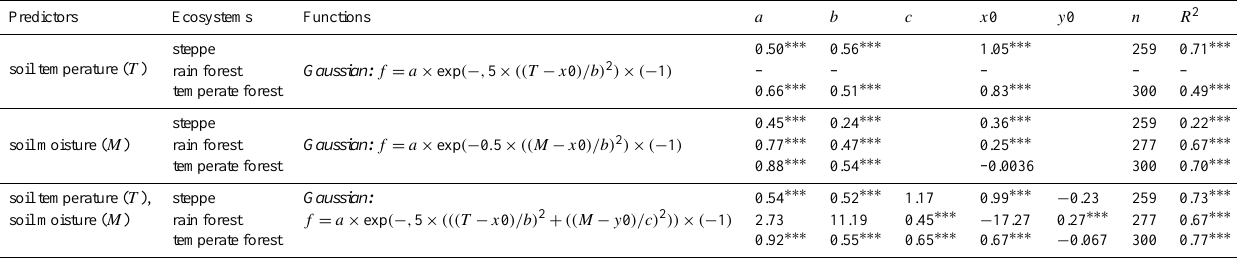
Table 3. Temperature and moisture control on methane fluxes.